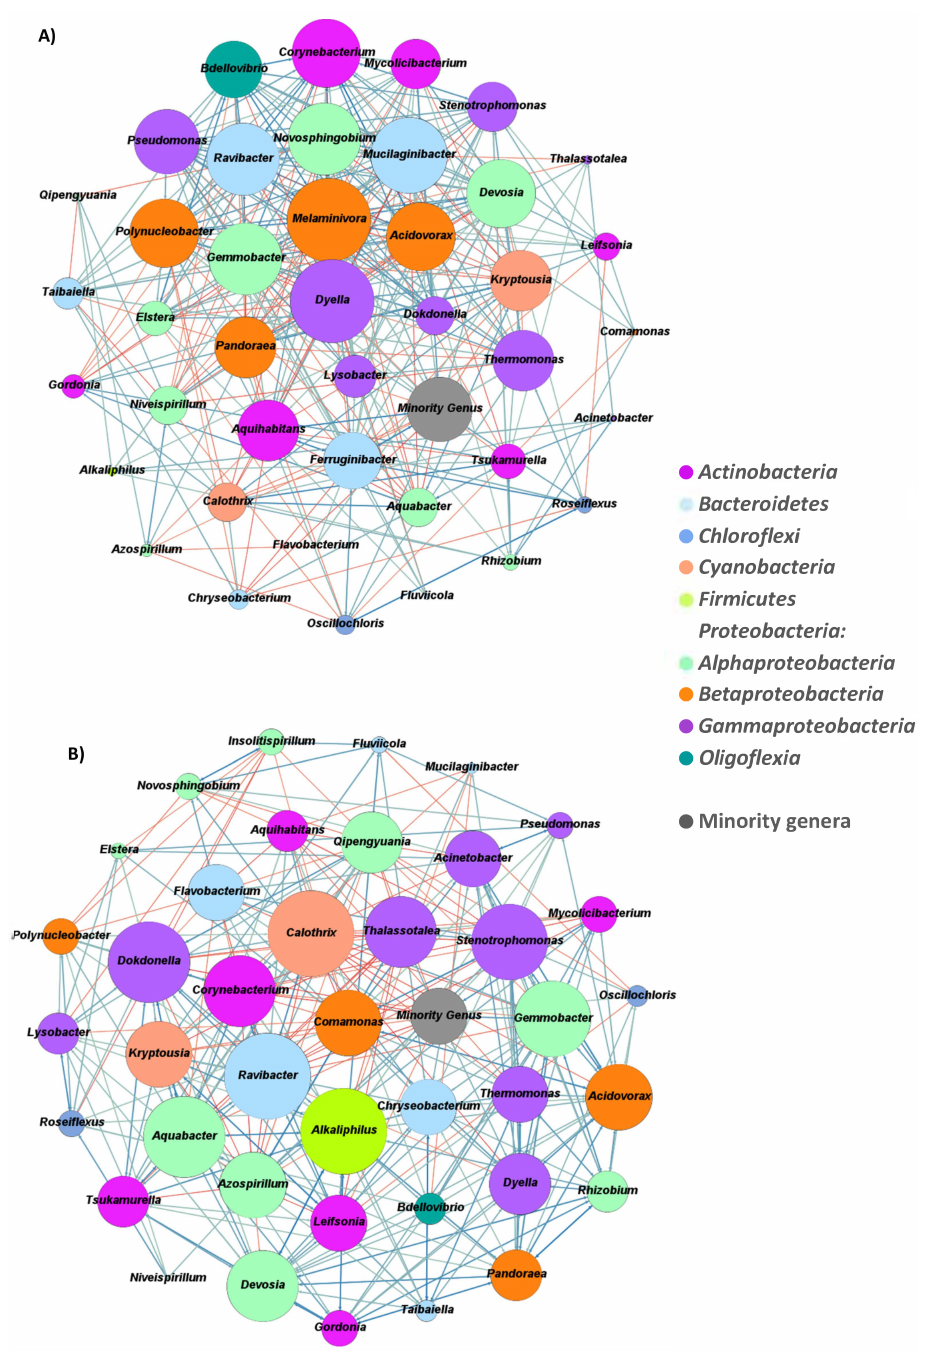
Figure 7. Co-occurrence networks of the significant Spearman’s rank correlation coefficients ( ρ > 0.4) of the RAs of the dominant bacterial genera in biomass samples retrieved from two PHA- accumulating SBR reactors operated under ( A ) non-saline (SBR-N) and ( B ) saline (SBR-S)